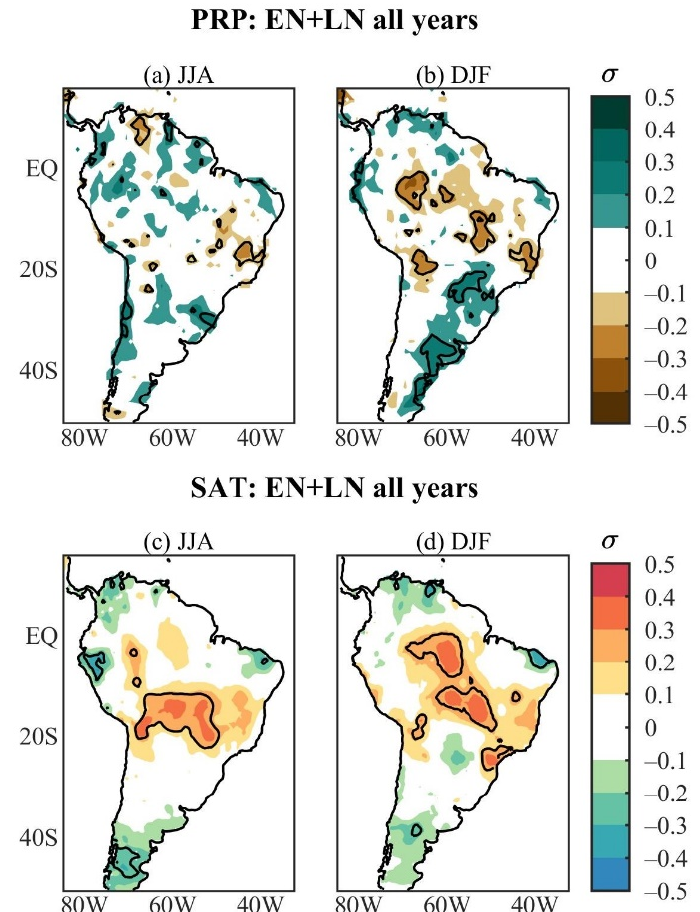
Figure 1. Austral summer and winter nonlinear standardized anomaly patterns of all ENSO events during the 1901–2014 period for ( a , b ) PRP and ( c , d ) SAT. Continuous contours encompass the significant anomalies at a 90% confidence level using the Student’s t -test. The symbol σ above the colour bar means standard deviation.